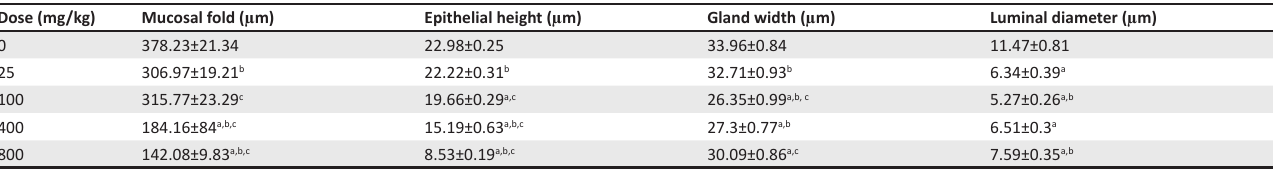
a, Differ significantly from control; b, A significant change between carbendazim treatment groups; c, A significant change between carbendazim treatment